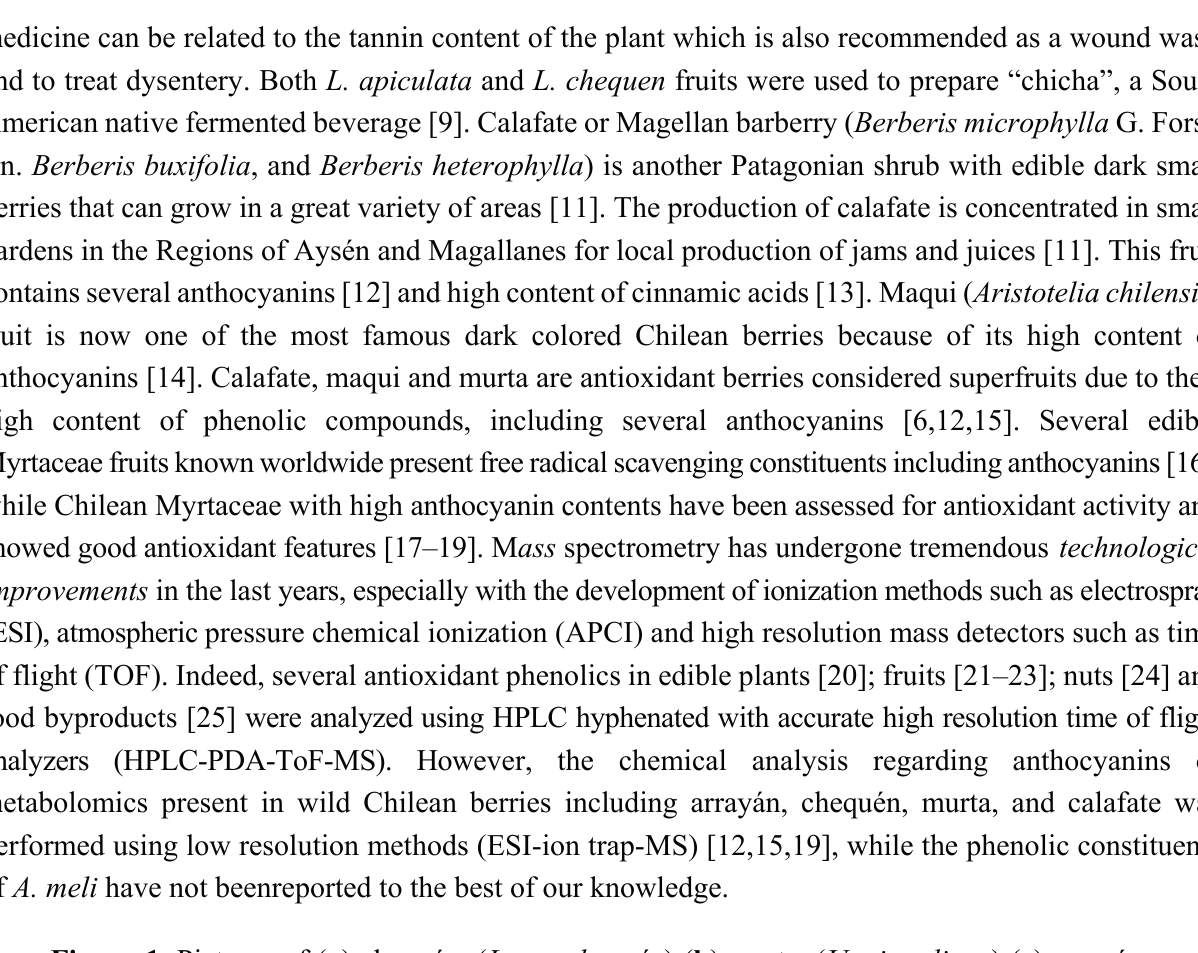
Figure 1. Pictures of ( a ) chequén, ( Luma chequén ) ( b ) murta, ( Ugni molinae ) ( c ) arrayán, ( Luma apiculata ), ( d ) blueberries, ( Vaccinium corymbosum ) ( e ) meli, ( Amomyrtus meli